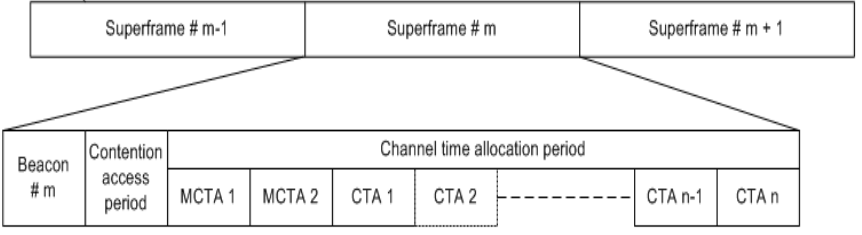
Figure 2. Superframe Structure of IEEE